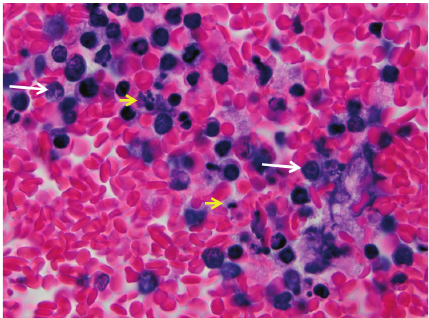
Figure 1: The pericardial fluid was bloody. Within the erythrocytes, numerous atypical intermediate to large cells were seen. Many of the cells had a vesicular chromatin and 1–3 prominent nucleoli (white arrows). Conspicuously, there were numerous apoptotic debris and histiocytes with ingested debris (yellow arrows).